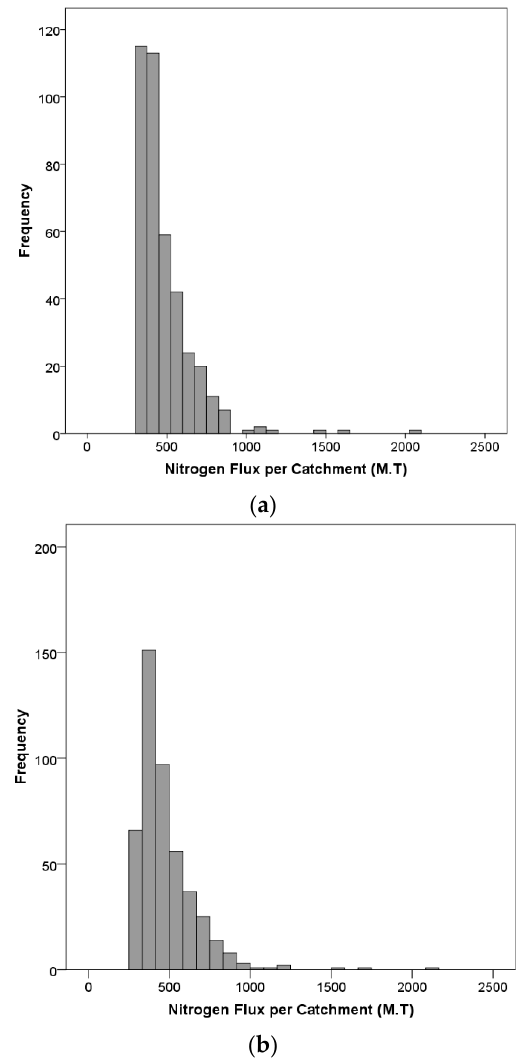
Figure 7. Distribution of nitrogen flux per catchment area for the 2015 mandate ( a ) and for the 2022 mandate ( b ).